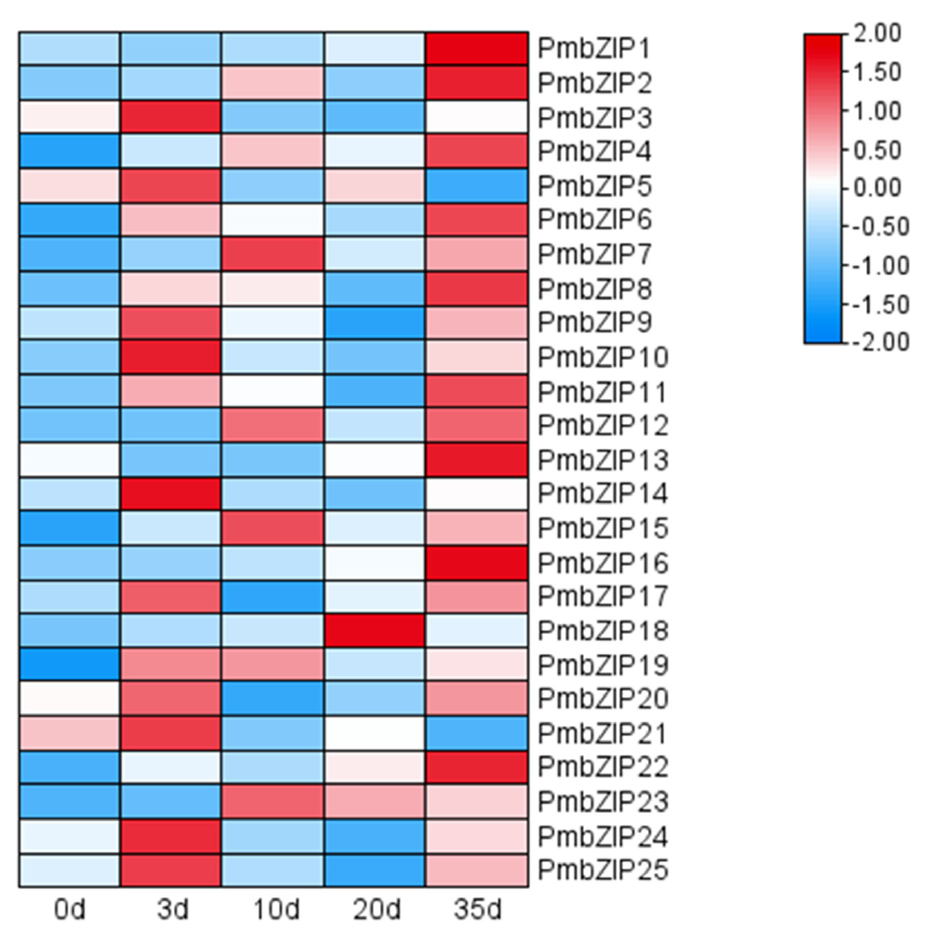
Figure 5. Transcriptional profiles of PmbZIP family members after inoculation with pine wood nematodes in P. massoniana corresponding to five stages: 0 (CK), 3, 10, 20, and 35 d. A heatmap was generated by the log 2 (FPKM + 1) value, and the color scale represents the relative expression level. 3.7. Expression Patterns of Selected PmbZIPs in Various Parts of the Plant According to the transcriptional profile of P. massoniana inoculated with pine wood ne- matodes, five representative PmbZIP ( PmbZIP3 , PmbZIP4 , PmbZIP8 , PmbZIP20 , PmbZIP23 ) genes with significantly up-regulated expression were chosen. The qRT–PCR technology was used to analyze the expression of PmbZIP genes in different parts. The results in Figure 6 show that PmbZIPs were expressed in young needles, mature needles, roots, and stems but at different levels. Among these genes, PmbZIP3 , PmbZIP8 , and PmbZIP20 were found to exhibit high expression levels in the roots. PmbZIP23 was observed to have higher expression in young needles than in other tissues. PmbZIP4 showed similar expression patterns in young needles, mature needles, and roots, which were slightly higher than those in the